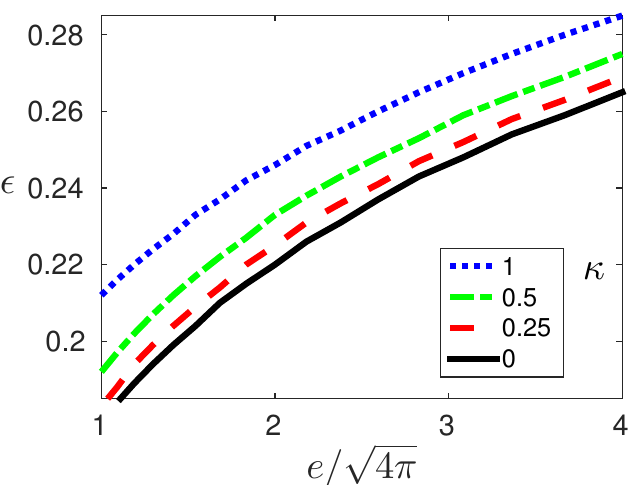
Figure 4. The line patterns (solid line, dashed line, dash-dotted line, dotted line) represent the critical value ǫ c as a function of e for κ = (0 . 00 , 0 . 25 , 0 . 50 , 1 . 00), respectively. For ǫ metastable vortex solutions were